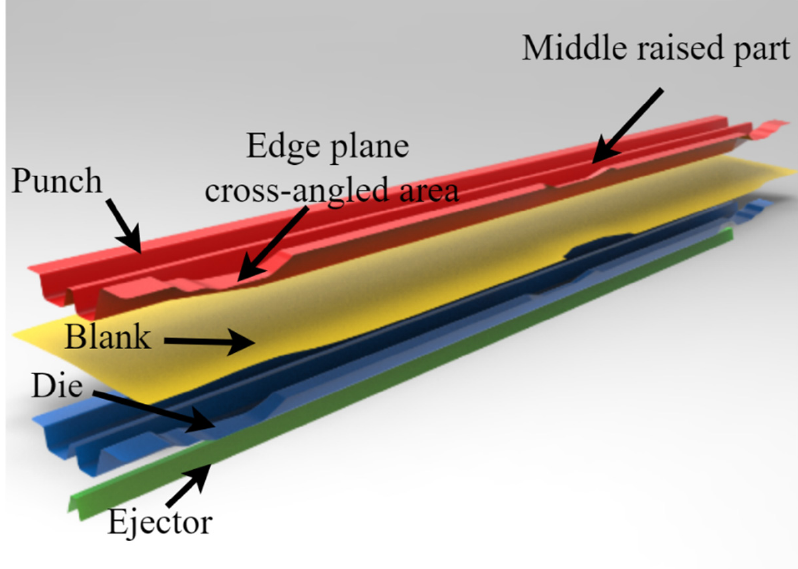
Figure 4. The finite element model for tests.